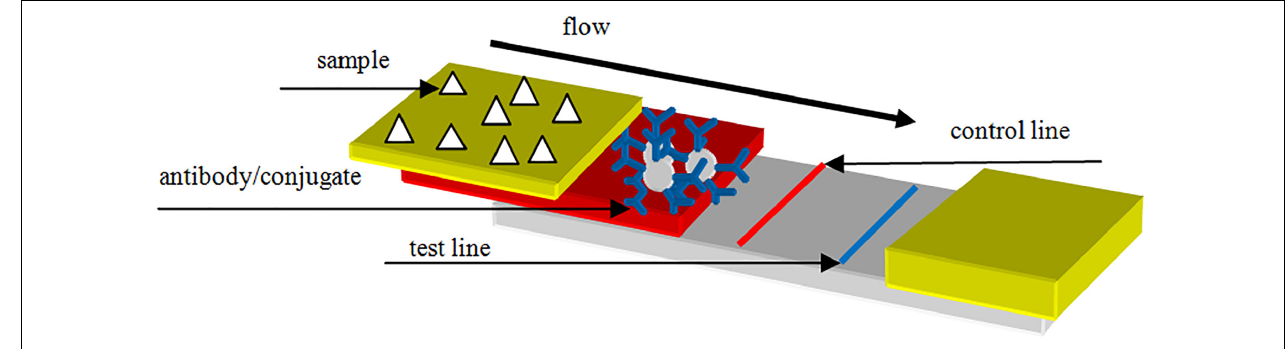
FIGURE 4 | Structure of lateral flow